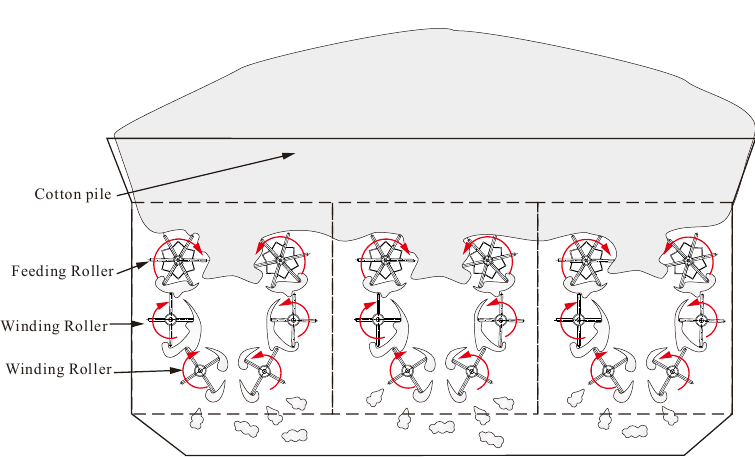
Figure 3. 3-Module design of multi-roller cleaning system.